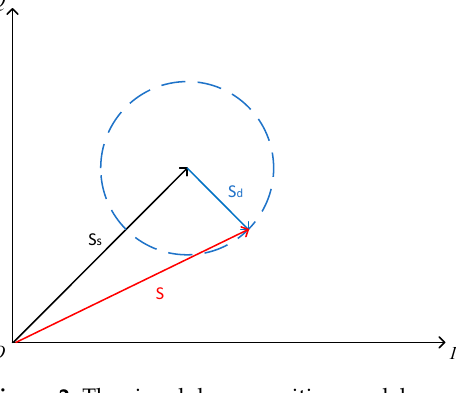
Figure 2. The signal decomposition model.